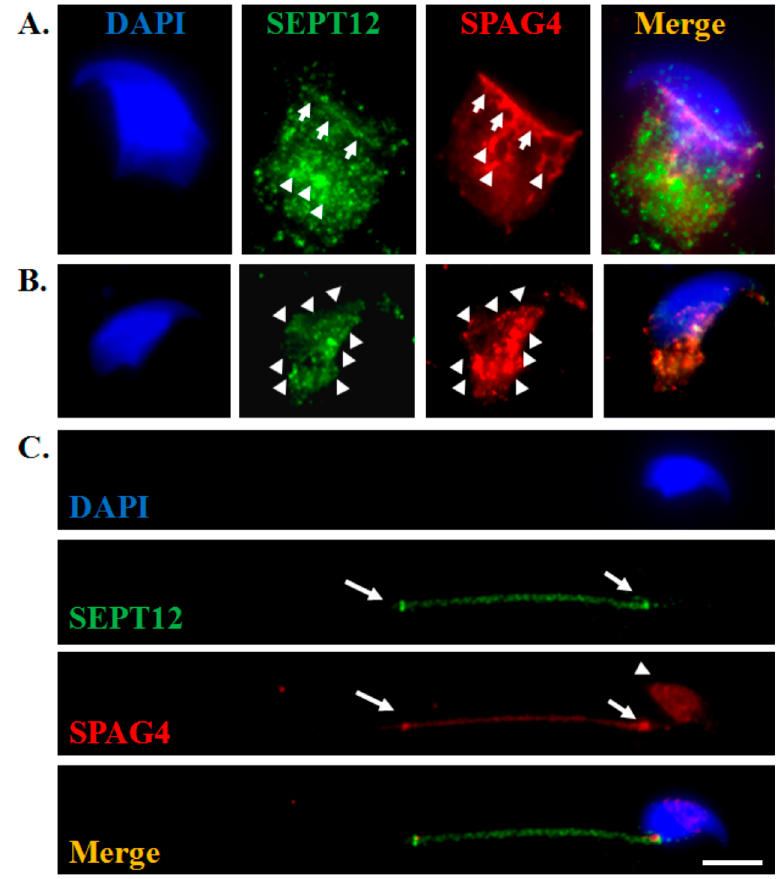
Figure 1. Colocalization of SEPT12 and SPAG4 during murine spermiogenesis. The testis collected from C57BL/6 mice ( n = 3) were separated according to the male germ cells’ stages. The images at different developmental stages were captured, some of which are presented in the Figure. From left to right: DAPI staining (blue), SEPT12 signal (green), SPAG4 (red), and merging of DAPI, SEPT12, and SPAG4 at the elongating spermatids ( A ), elongated spermatids ( B ), and mature sperm ( C ). ( A ) Arrows indicate signals within the edges of the acrosome and manchette. Arrowheads indicate signals located at the manchette. ( B ) Arrowheads indicate signals within the manchette. ( C ) Arrows indicate signals located at the neck and annulus of mature sperm. Arrowheads indicate SPAG4 signals around the sperm head. Scale bar: 5 μ m.